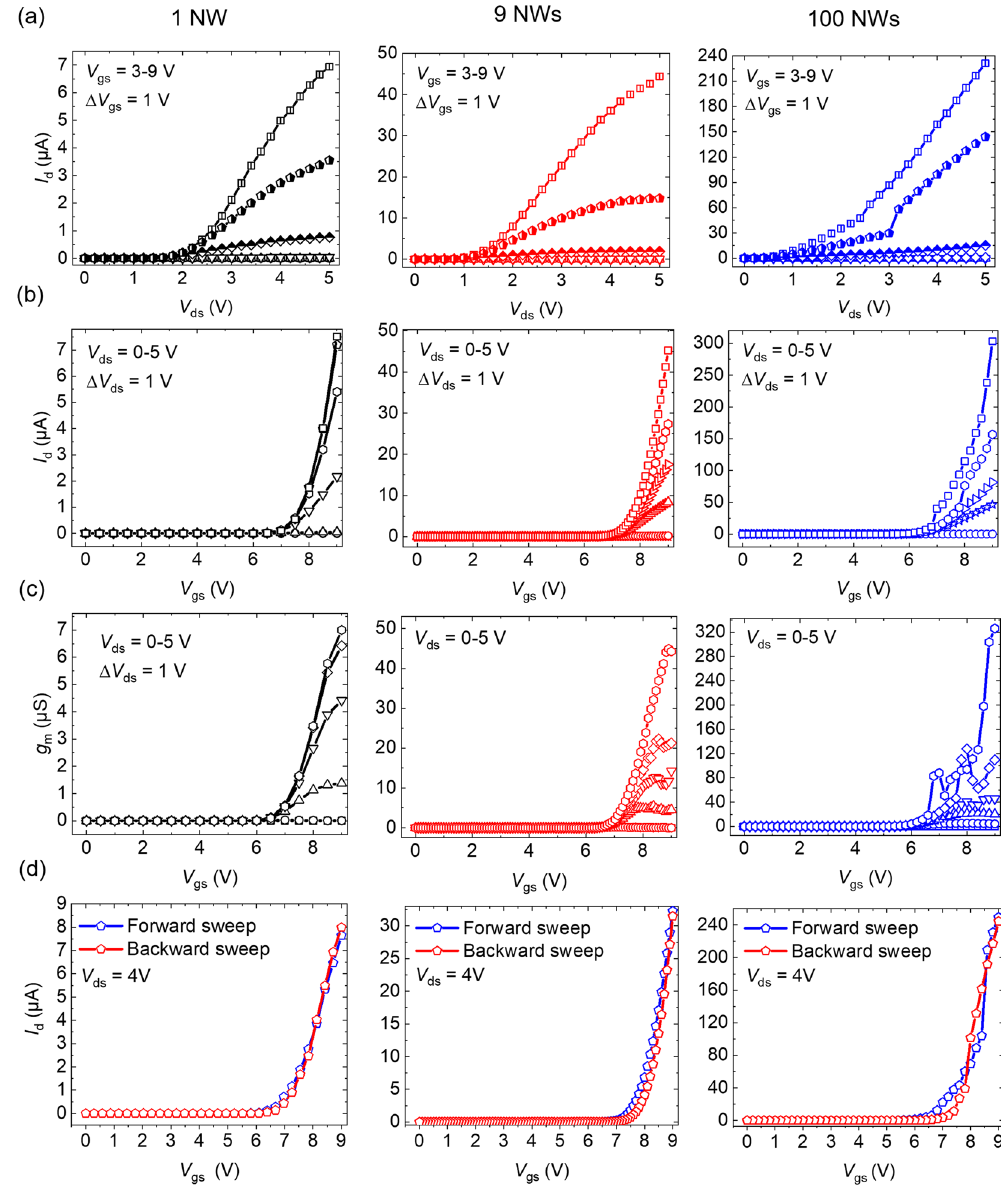
Figure 4. ( a ) Output characteristic, ( b ) transfer characteristic, ( c ) transconductance ( g m ), and ( d ) dual sweep mode transfer characteristic (sweep rate of 0.8–1 V/s) of 1, 9, and 100 n-p-n vertical GaN NW FETs with diameter of 440 nm at V ds = 4, respectively. All measurements were done in normal ambient condition (room temperature) for at least five sweep cycles on each FET device.